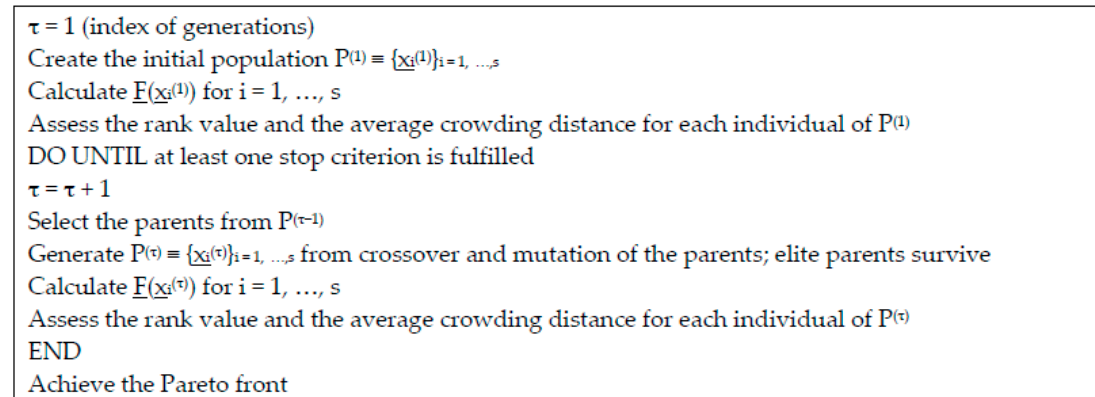
Figure 1. Scheme of the GA, adapted from [39].